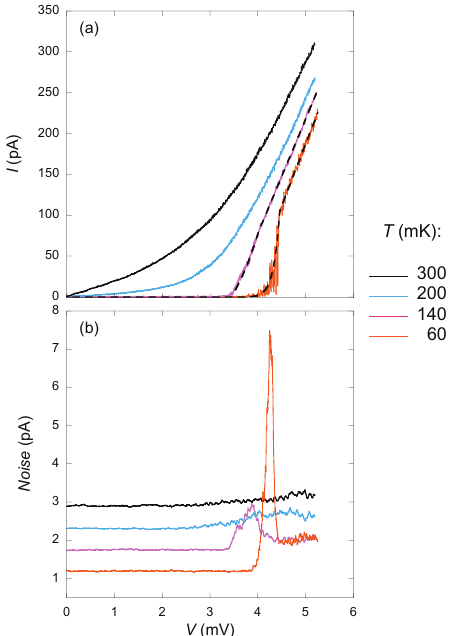
Figure 7. ( a ) V − I characteristics at n s = 5.36 × 10 10 cm − 2 in a silicon MOSFET for different temperatures. The dashed lines are fits to the data using Equation (6). ( b ) The broad-band noise as a function of voltage for the same electron density and temperatures. The three upper curves are shifted vertically for clarity. From